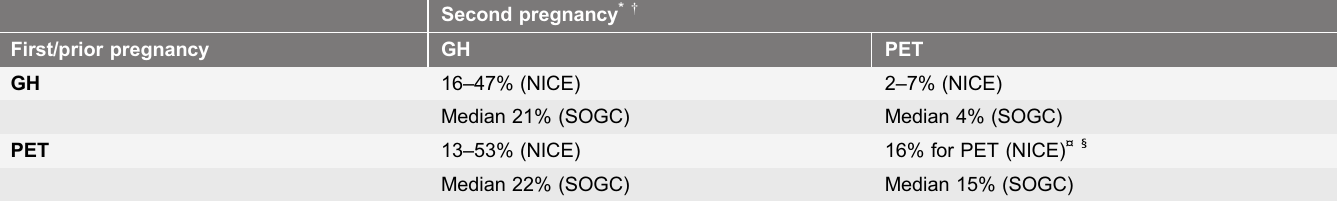
*Recurrence more likely in women with higher BMI, and when the prior PET was: of early onset, ‘‘severe’’, or complicated by eclampsia or HELLP syndrome